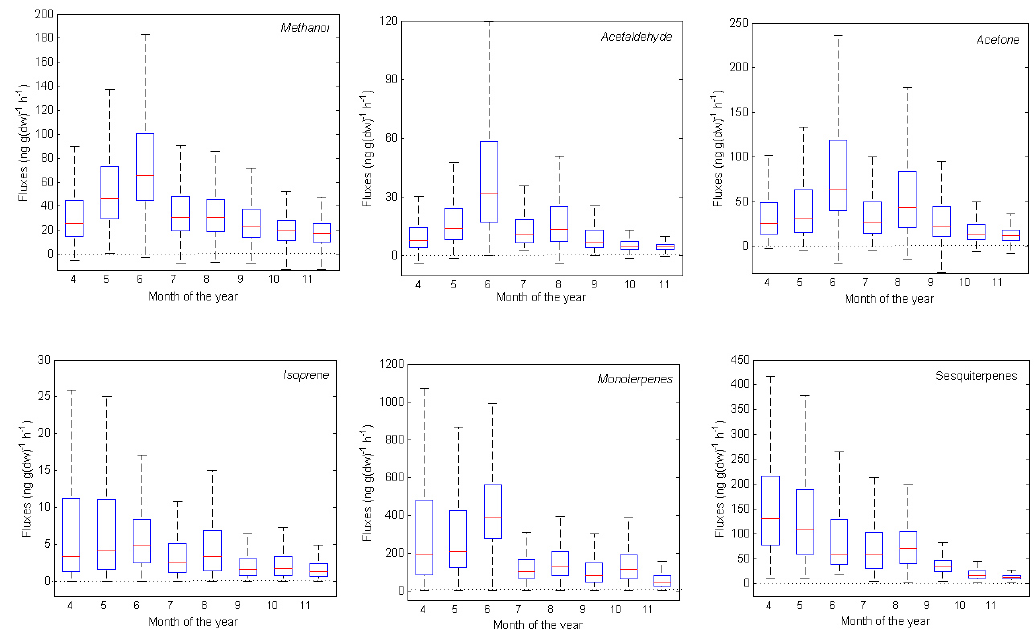
Figure 3. Box plot for the fluxes of the main oxVOC investigated (top) and for isoprenoids (bottom). On each box, the central mark is the median and the edges of the box are the 25th and 75th percentiles.